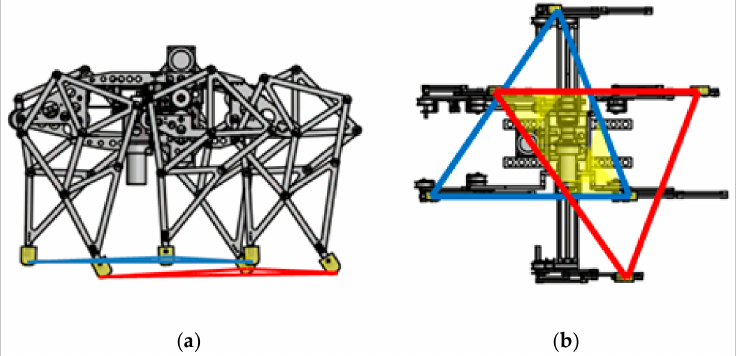
Figure 4. ( a ) Lateral view of two support triangles. ( b ) Bottom view of two support